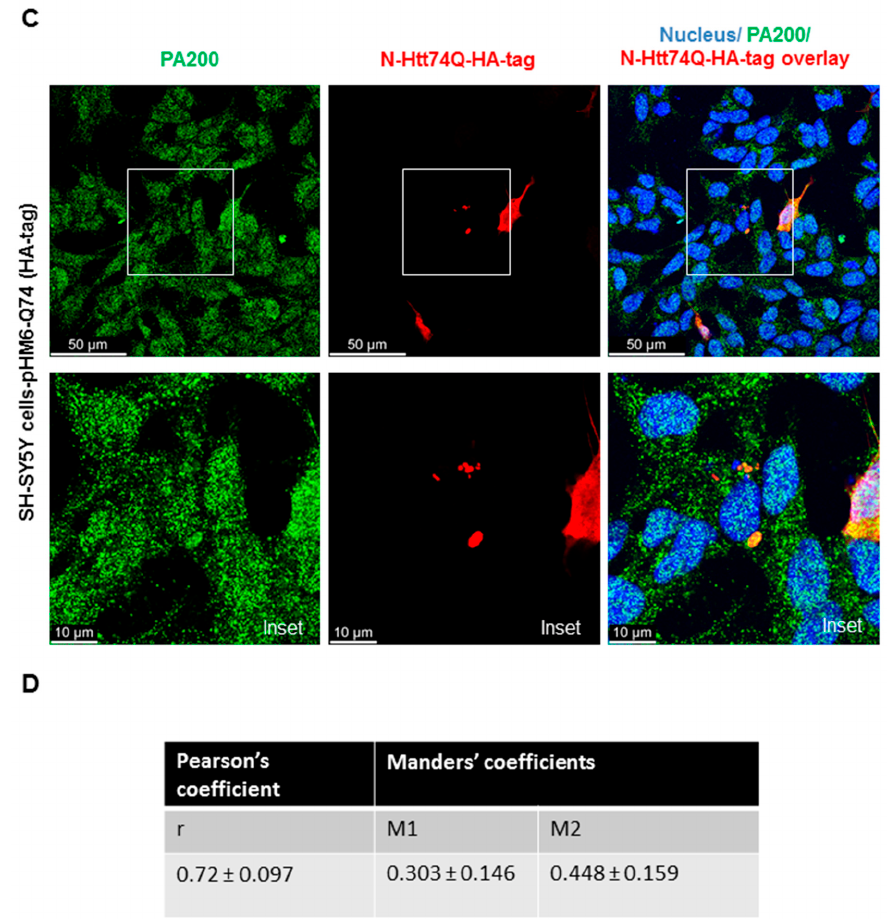
Figure 3. Endogenous PA200 show colocalization with N-Htt in SH-SY5Y neuroblastoma cells. Representative, merged immunofluorescence confocal images, Pearson’s and Manders’ coefficients showing colocalization of overexpressed N-Htt fragments and endogenous PA200. Cells were transfected with pHM6-Q23 and pHM6-Q74 plasmids for 48 h. Cells were immunolabeled with anti-HA-tag/Alexa Fluor 594 for Q23 and Q74 and with anti-PA200/Alexa Fluor 488 antibodies for PA200. DAPI was used to stain the cell nuclei. ( A , C ) The colocalization between N-Htt and PA200 is indicated by Pearson’s cross-correlation coefficient (r value) and Manders’ coefficients (M1, M2). Values were obtained by using the JACoP plugin in ImageJ. The data are presented as mean ± SD obtained from 28 images of cells expressing the N-Htt23Q with HA-tag and 24 images of cells expressing the N-Htt74Q with HA-tag. ( B ) The table shows r value between N-Htt23Q-HA-tag and PA200, M1 indicates the fraction of N-Htt23Q-HA-tag overlapping PA200, and M2 indicates the fraction of PA200 overlapping N-Htt23Q-HA-tag. ( D ) The table shows the values of r, the M1 value between N-Htt74Q-HA-tag and PA200, and the M2 value between PA200-N-Htt74Q-HA-tag. To determine if PA200 interacts with the N-Htt-fragments, pull-down assays were performed to check the ability of the recombinant GST-Htt18Q and GST-Htt51Q to bind endogenous PA200 from